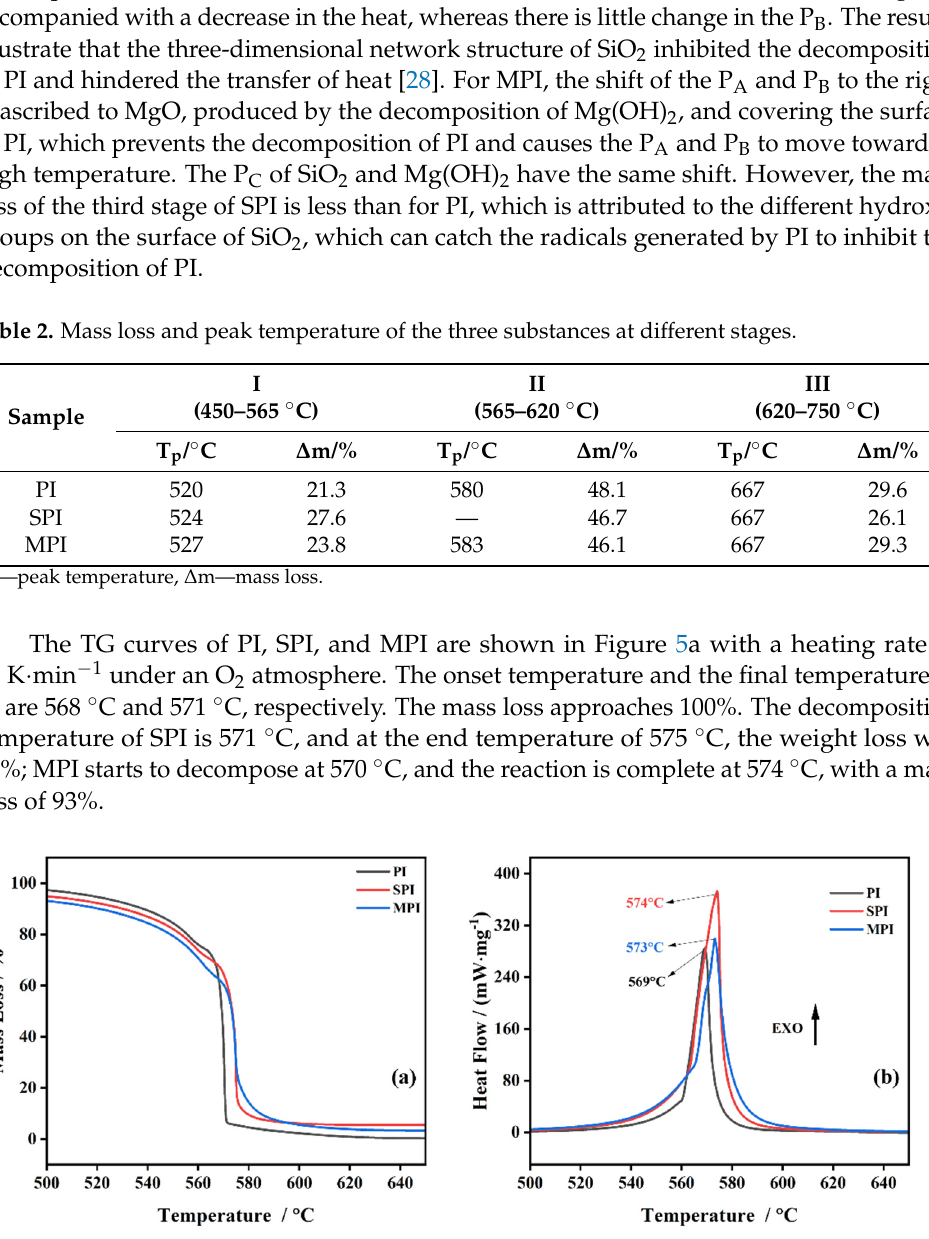
Figure 4. TG ( a ) and DSC ( b ) curves of three substances under an N 2 atmosphere.